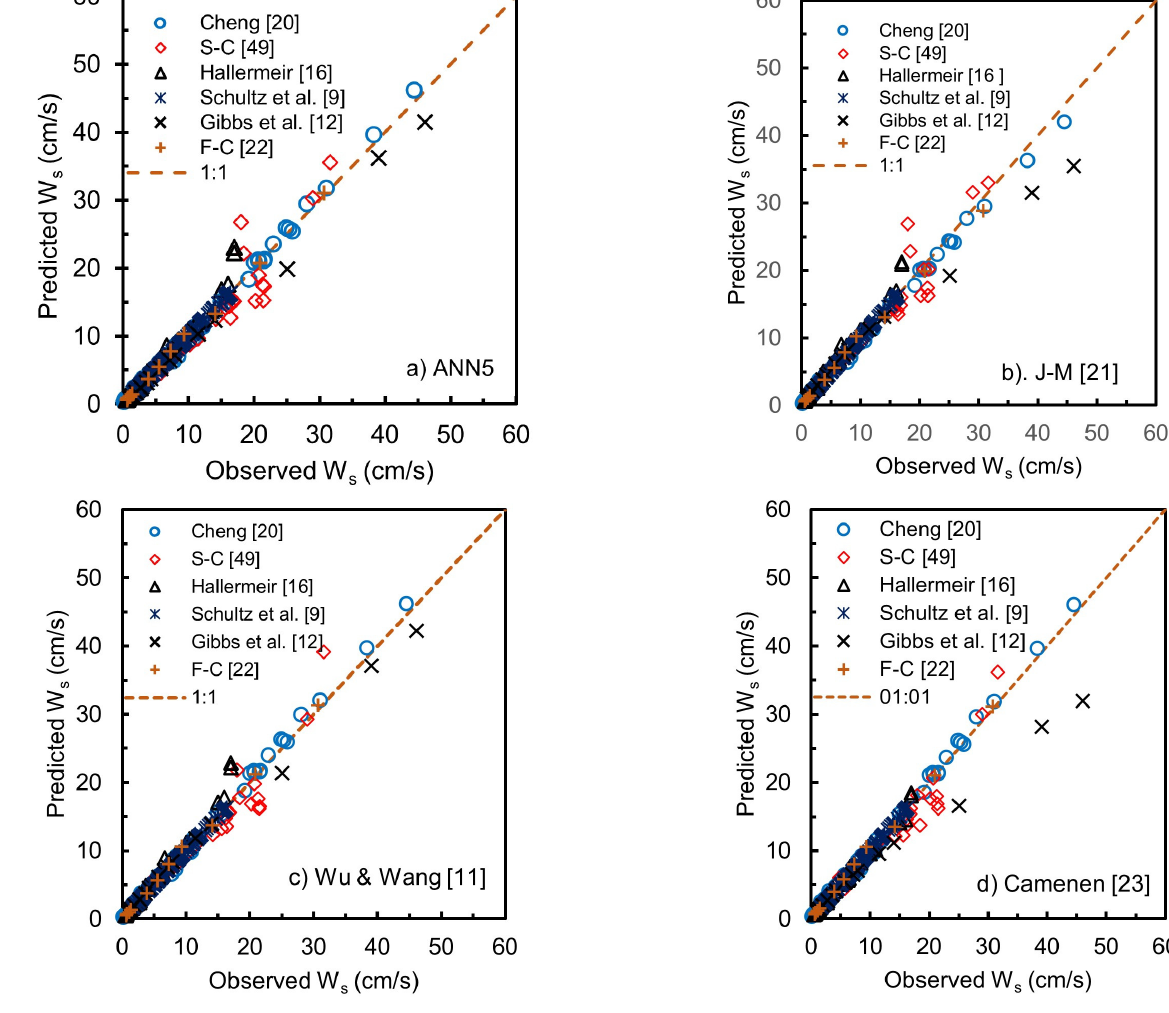
Figure 9. Scattering plot for results of testing 2 for equations of ANN5 ( a ); Jiménez and Madsen [21] ( b ); Wu and Wang [11] ( c );.and Camenen [23] ( d ).